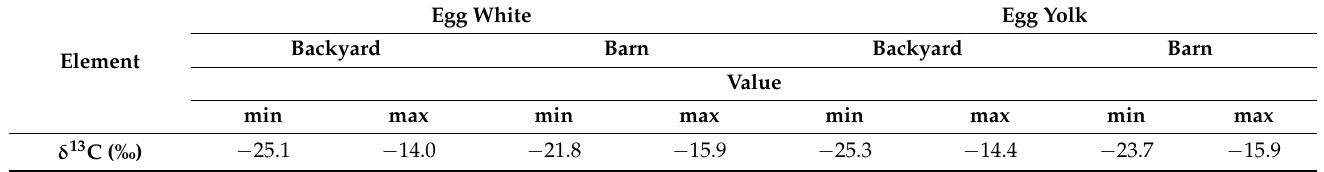
Table 1. The minimum (min) and maximum (max) values of elements having the highest classification power according to hen rearing